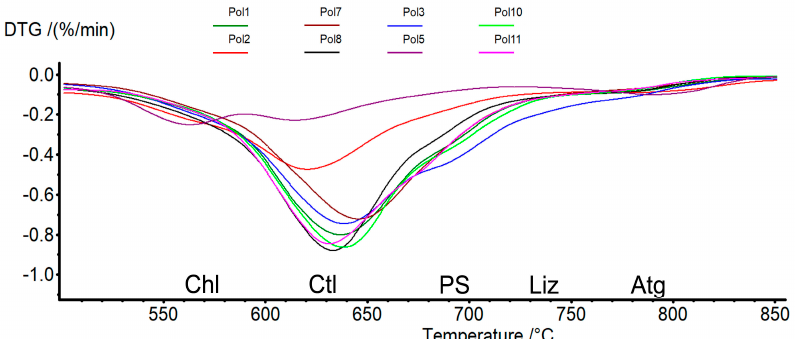
Figure 7. Comparison among DTG curves in the temperature range of 500–850 °C: endothermic peaks related to chlorite (Chl), chrysotile (Ctl), polygonal serpentine (PS), lizardite (Liz) and antigorite (Atg) decomposition.